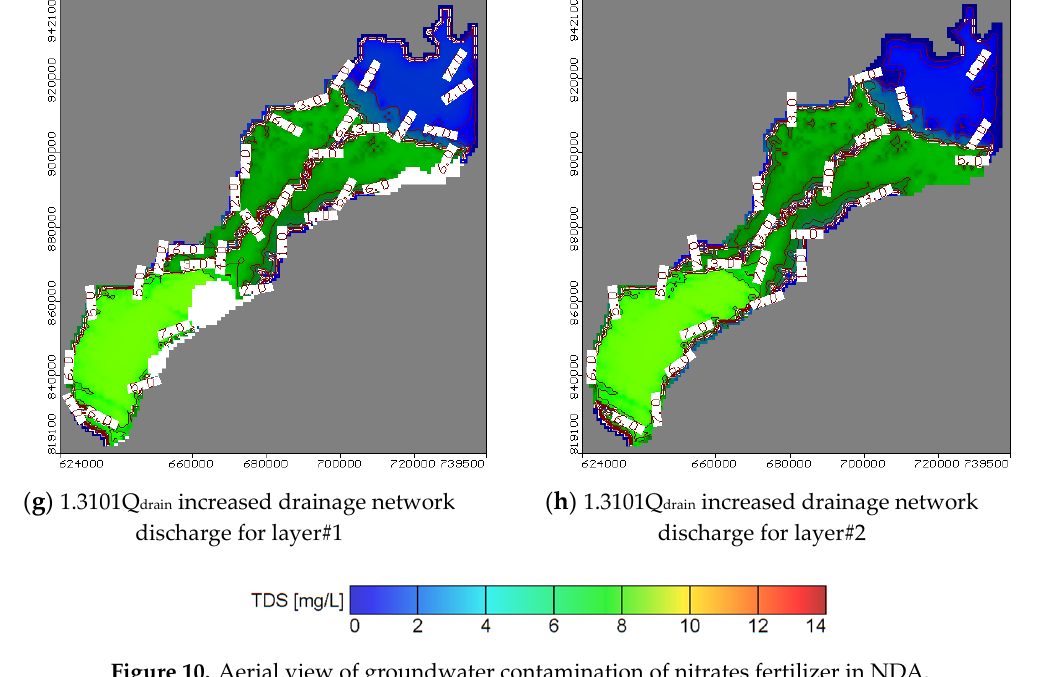
Figure 10. Aerial view of groundwater contamination of nitrates fertilizer in NDA.